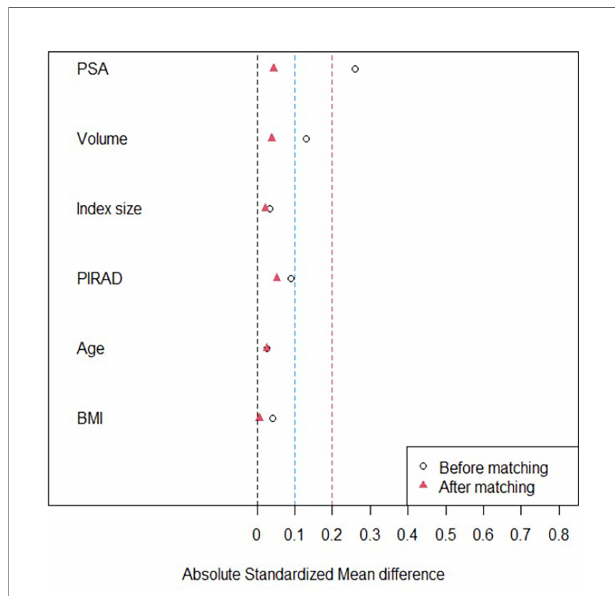
FIGURE 4 | A graph illustrating the change of standardized mean difference (SMD). The SMDs of PSA, prostate volume, and PI-RADS scores are signi fi cantly reduced to 0.1 or less after propensity score matching. However, the SMDs of other baseline characteristics such as age, body mass index (BMI), and so on are not siginifcantly different before and after